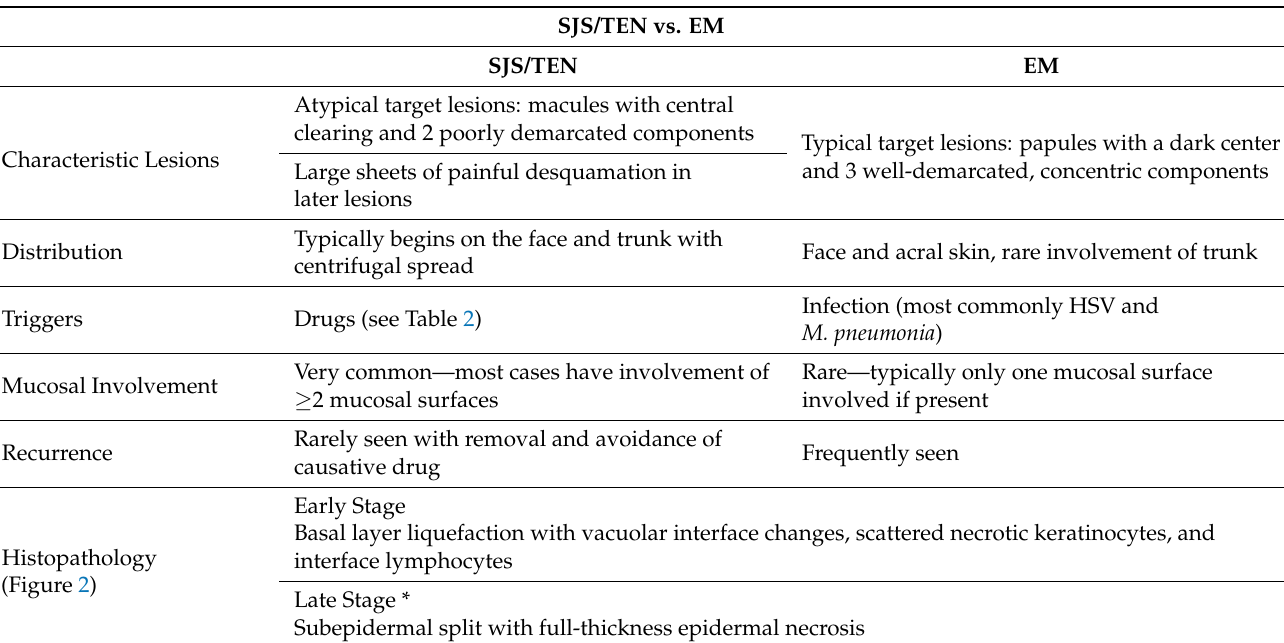
Table 4. Distinguishing characteristics of SJS/TEN and